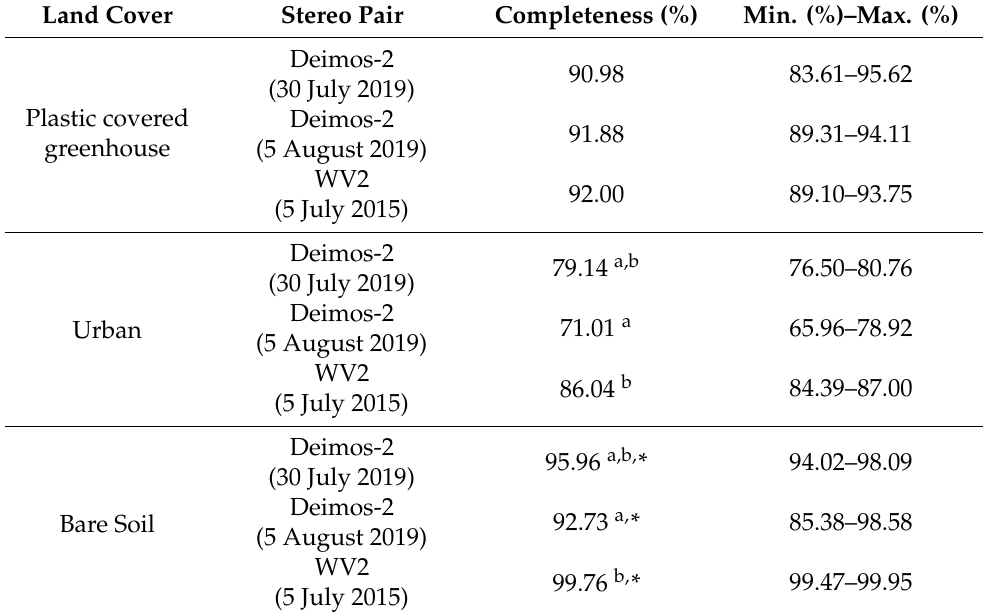
Table 5. Mean and range of completeness values (maximum and minimum) attained from the three samples per land cover. For each land cover, di ff erent superscript letters between data along the completenesscolumnindicatesignificantdi ff erencesatasignificancelevel p < 0.05(*indicatesdi ff erences at a significance level p <